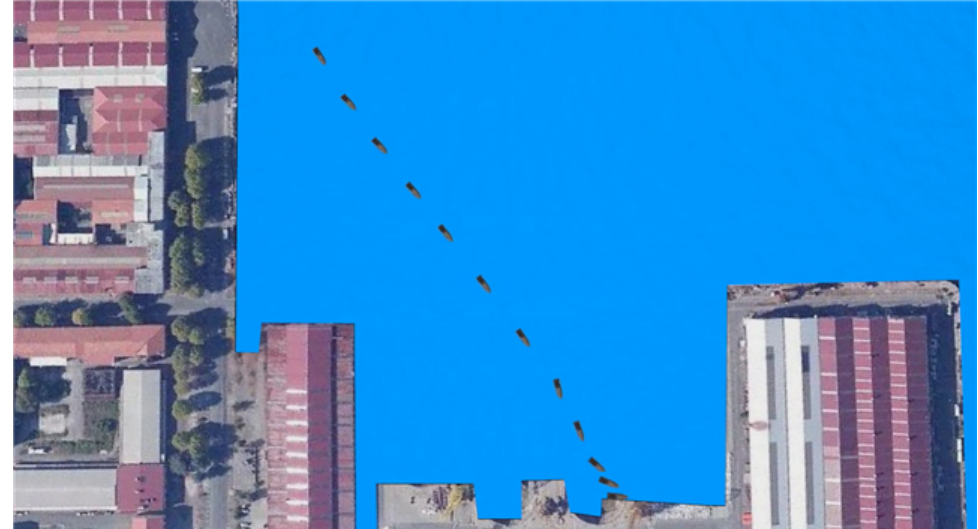
Figure 15. Trajectory of the USV when parallel-type berthing was performed using MRAC.